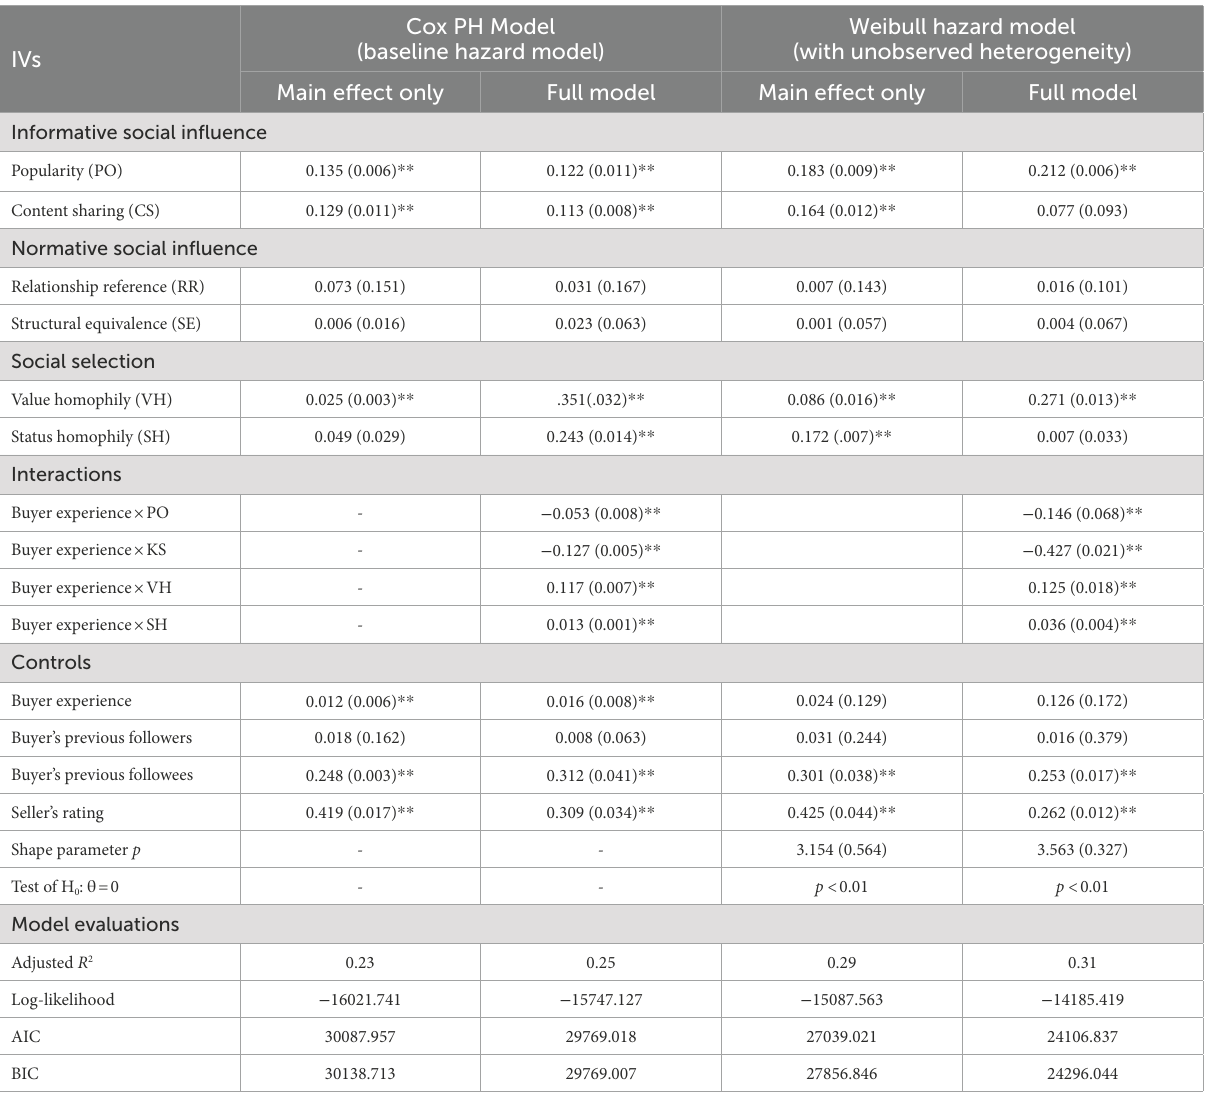
TABLE 3 Ties emergence model estimation and